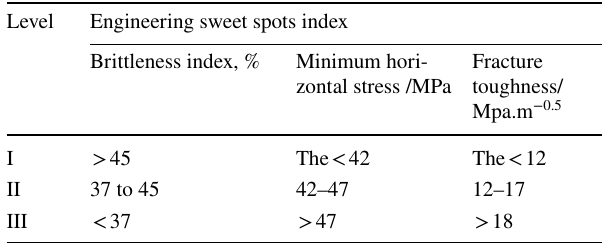
Fig. 18 Minimum horizontal principal stress Table 2 Classification summary of single index of engineering sweet spots2